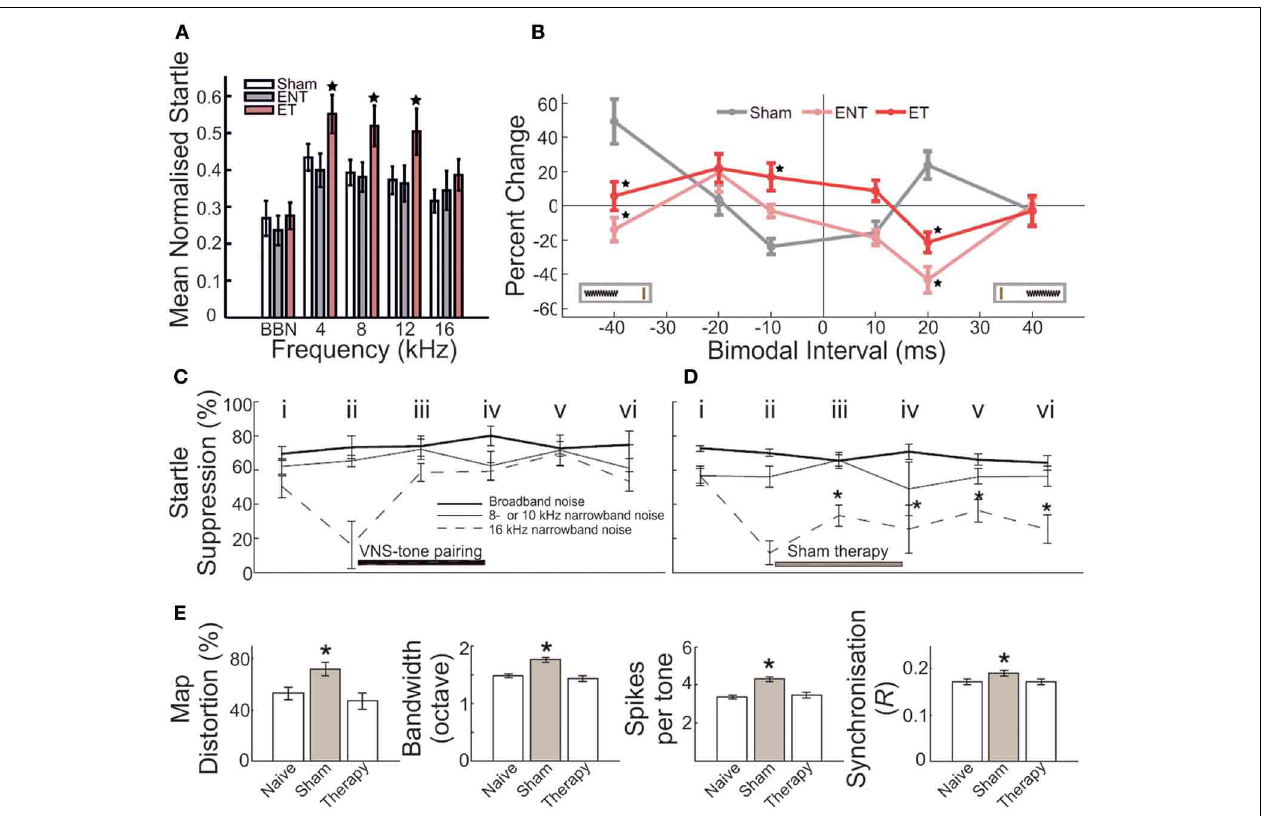
FIGURE 6 | Gap-prepulse inhibition of the acoustic startle reflex (GPIAS) in rodents acts as a marker for underlying neurobiological changes following auditory insult. (A) In a cohort of adult guinea pigs, acoustic overexposure (1/4 octave band noise centered at 7kHz, 93dB SPL, 2h; twice-exposed, separated by 6–8 weeks) yielded a subset of animals that displayed significantly decreased normalized startle response inhibition for background masking in the 4–16kHz bandwidths. Sham controls = white bars; GPIAS-unimpaired animals = gray bars; GPIAS-impaired animals = pink bars. Star = significantly different ( p < 0 . 05) from other bars in the same frequency band (B) On the basis of categorization according to the presence of GPIAS deficits, this subset of animals displayed significantly different stimulus-timing dependent plasticity functions for bimodal somatosensory-auditory stimulation compared with both sham controls, and exposed but unimpaired animals. Sham = gray; GPIAS-unimpaired = pink; GPIAS-impaired = red. Modified with permission from Koehler and Shore (2013a). (C–E) Following exposure to acoustic trauma (octave band noise centered at 16kHz, 115dB SPL, 1h), adult rats underwent daily pairing of tonal stimuli outside the 8–10kHz frequency bandwidth, either with vagal